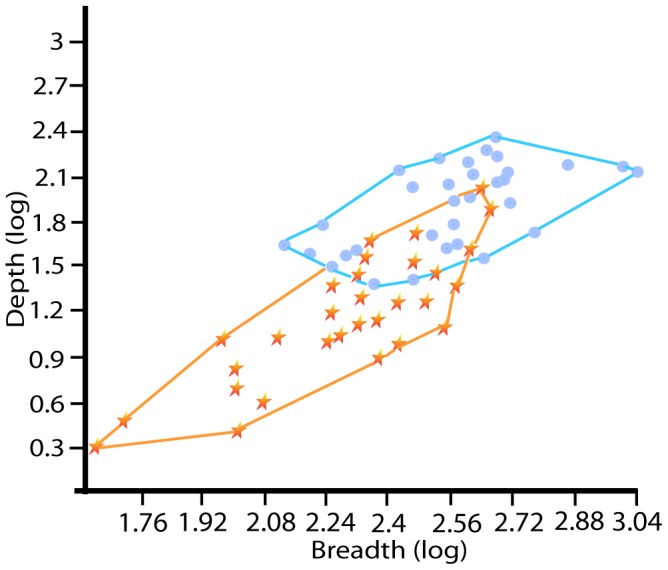
Convex hulls of cut-mark cross-sectional breadth and depth (µm) for surface modifications on aquatic (red star) and terrestrial (blue dot) bone surfaces.